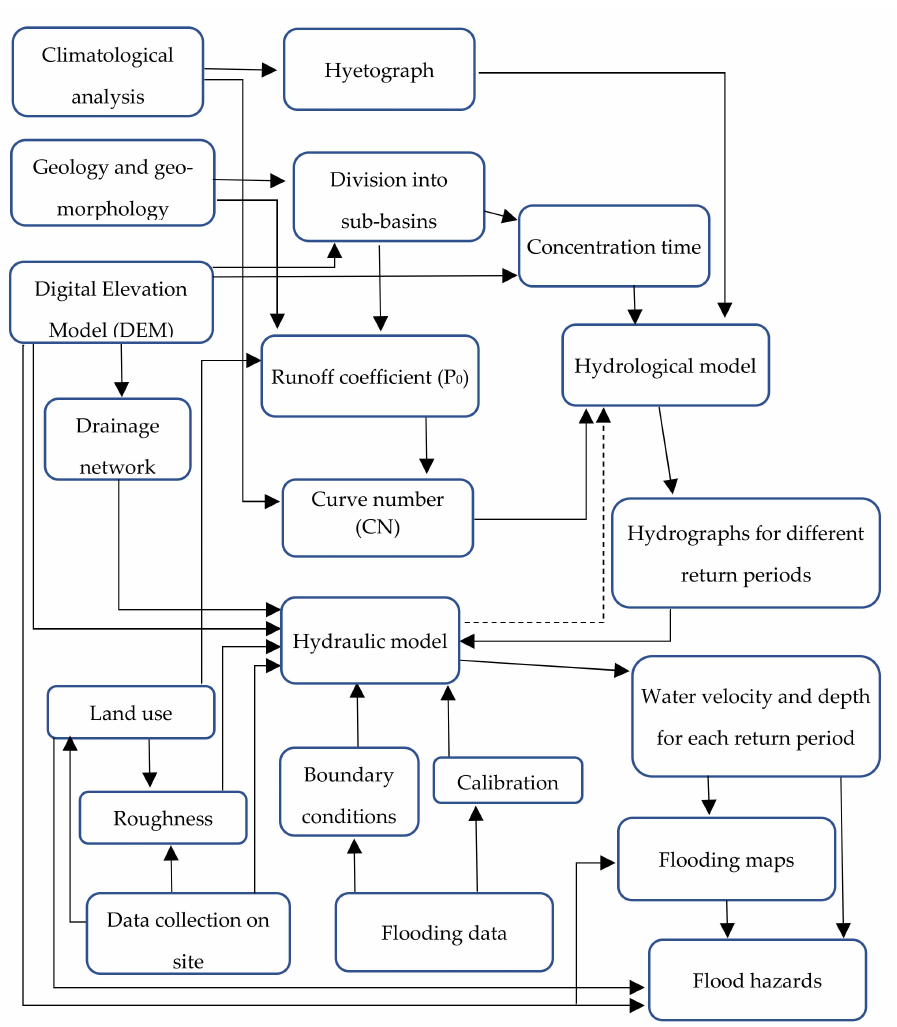
Figure 3. Methodological scheme for developing flood studies at flat coastal areas of the Eastern Iberian